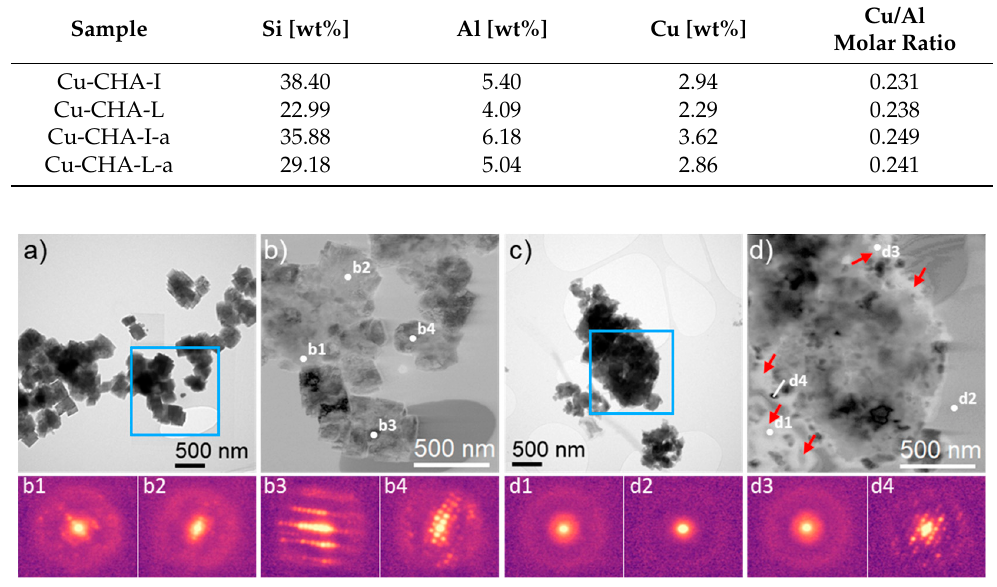
Figure 1. TEM bright field images (TEM-BF, ( a , c )) for reference and corresponding difference images (index map superimposed on VBF, ( b , d )) of Cu-CHA-L-a ( a , b ) and Cu-CHA-I-a ( c , d ). Difference images show enlarged regions marked by the reticule in ( a , c ). Local nanodiffraction patterns (false colored) acquired by SEND of Cu-CHA-L-a ( b1 – b4 ) and Cu-CHA-I-a ( d1 – d4 ) correspond to positions indicated by the markers in ( b , d ). Completely amorphized regions visible in Cu-CHA-I-a material, as shown in ( d ) (red arrows and exemplarily marked with ( d1 , d3 )), are distinguishable by bright contrast in the difference image, whereas comparatively bright contrast regions in ( b ) (exemplarily marked with ( b1 , b2 )) show partially amorphized/low crystallinity Cu-CHA-L-a. A nanodiffraction pattern of the TEM carbon support film is shown for reference ( d2 ). Crystalline regions are distinguishable by darker contrast in the difference images, as referenced by crystalline nanodiffraction patterns ( b3 , b4 ) for Cu-CHA-L-a and ( d4 ) for Cu-CHA-I-a.